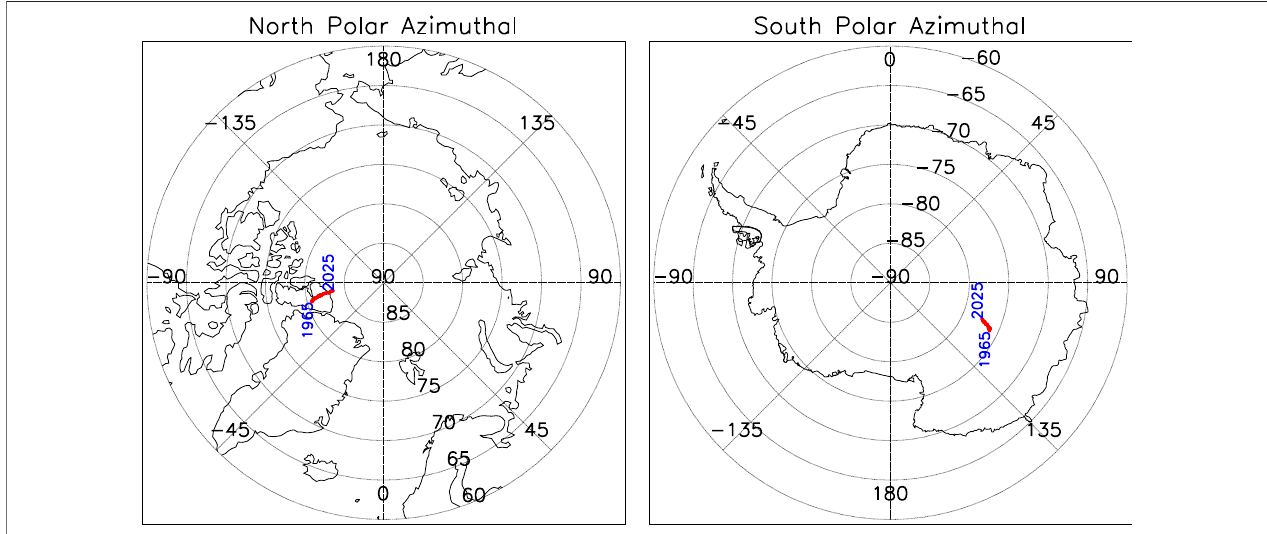
FIGURE 14 | Central location of the EPW for the rigidity of 1 GV for different years from 1965 to 2025 with the time resolution of 1 year.